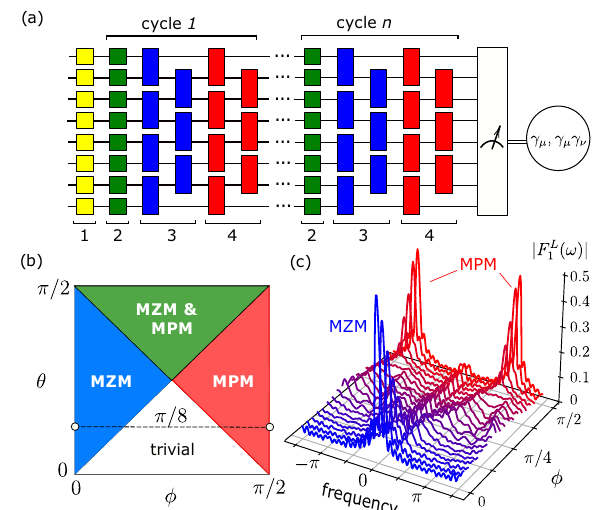
Fig.1|Circuitandphasediagram.a Schematicsofan8-qubitcircuitincludingthe initialization, evolution, and measurement parts. The initialization process is lim- ited to the application of single-qubit Hadamard gates (yellow, #1). Evolution is composed of cycles consisting of Z gates (green, #2), XX gates (blue, #3), and ZZ gates(red,#4).Themeasurementsprovidetheexpectationoftheoperators γ L , R μ or γ μ γ ν (see “ Methods ” section). b Phase diagram for λ =0, showing four possible phases, see text. c Experimentally measured Fourier component ∣ F L 1 ð ω Þ ∣ as a func- tion of ϕ for fi xed θ = π /8 using a 21-qubit system implemented on ibm_hanoi . The system exhibits transitions from MZM to trivial phase and from trivial to MPM phase. Detected peaks indicate the presence of Majorana modes at frequencies ω =0 and ω = π